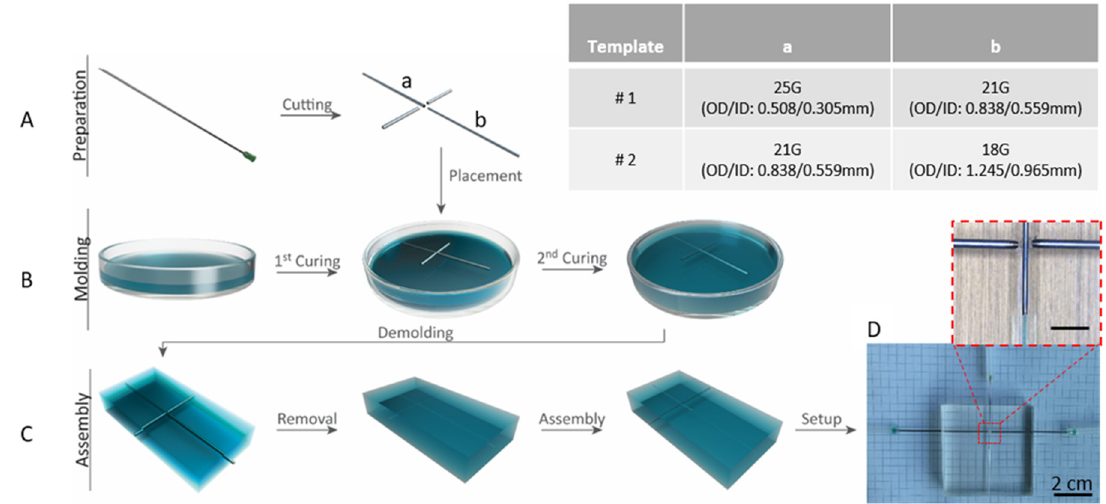
Figure 1. Schematic illustration of the fabrication procedure of the microfluidic spinnerets. ( A ) Preparation of the channel templates with different needles (OD: outer diameter; ID: inner diameter). ( B ) PDMS cross-linking and molding into the device features. ( C ) Assembly of the microfluidic spinneret. ( D ) A representative photograph of the final product with inset showing the detail of the microfluidic channels (inset scale bar: 5 mm).